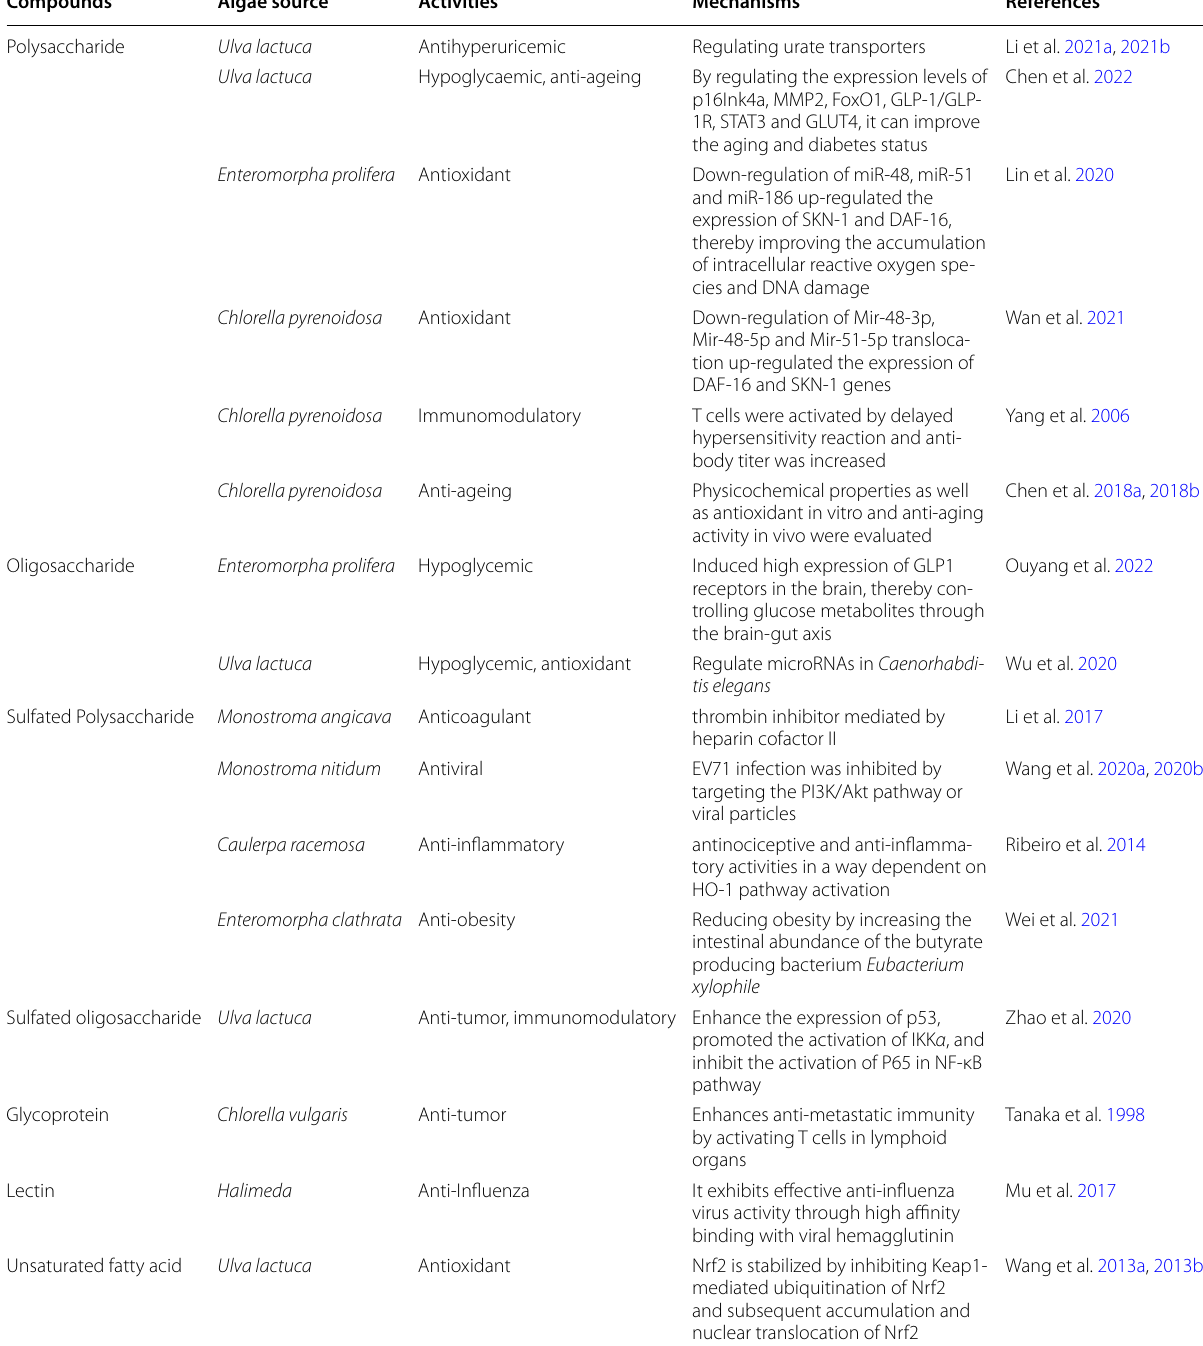
Table 3 The bioactivity and characteristics of green seaweeds